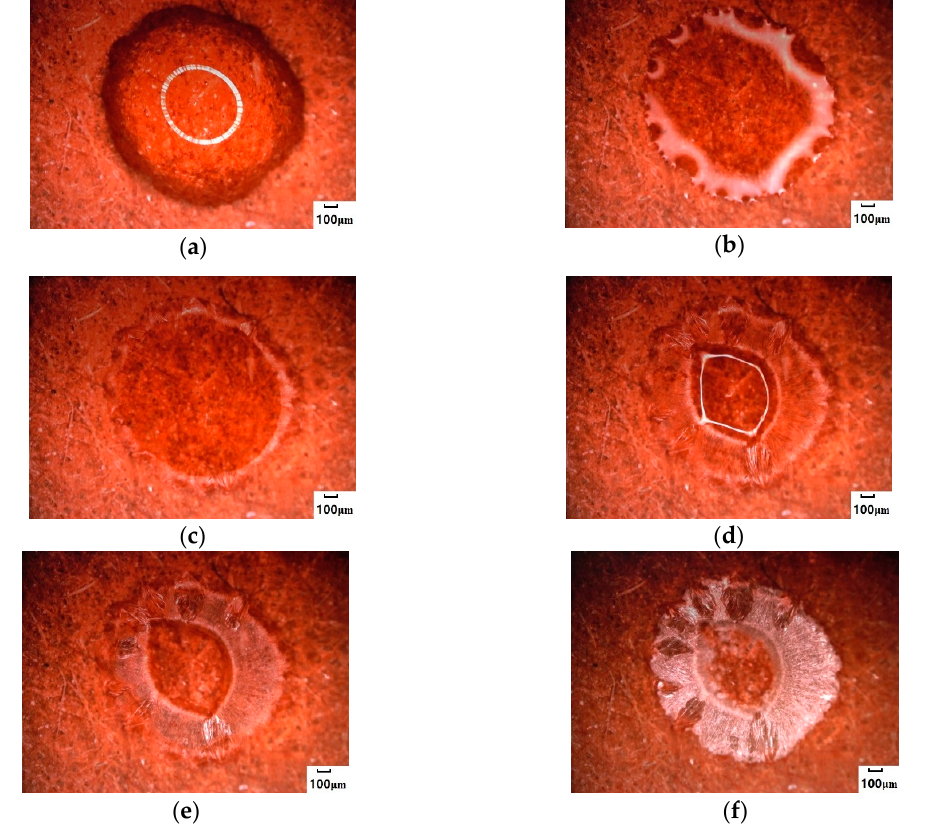
Figure 3. Crystallization process of Na 2 SO 4 salt droplets on the surface of hydrophilic media. ( a ) Droplets. ( b ) The edge of droplets began to crystallize. ( c ) The crystal area at the edge of droplets increased. ( d ) Crystals grew inwards. ( e ) Crystals were gradually desiccated. ( f ) Crystals were completely desiccated.